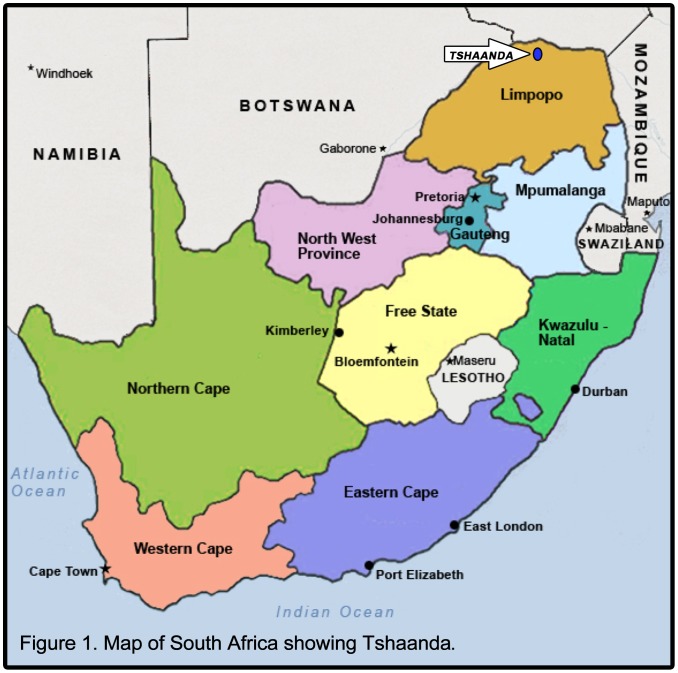
Map of South Africa showing Tshaanda.